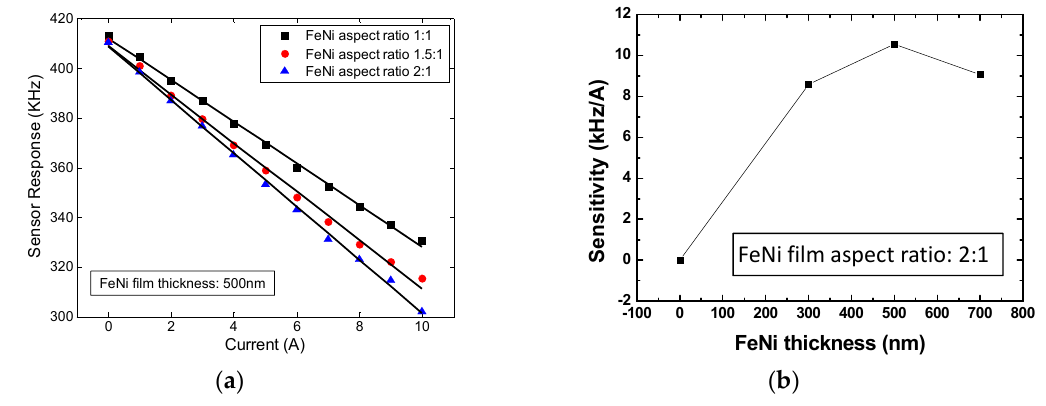
Figure 13. The effect on sensor response from the FeNi aspect ratio ( a ) and FeNi thickness ( b ).